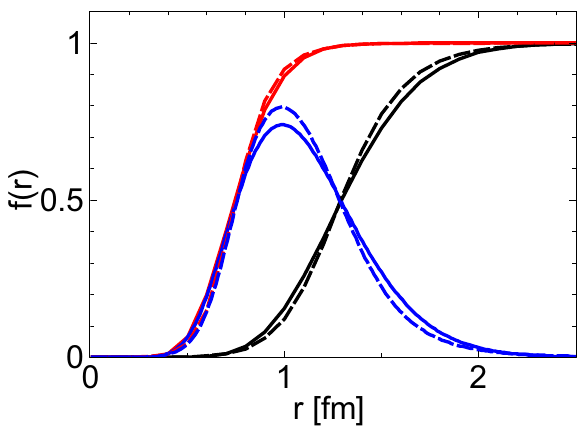
Figure 4: The regulator functions, Eq. (6) and Eq. (7). The meaning of the curves are described in the